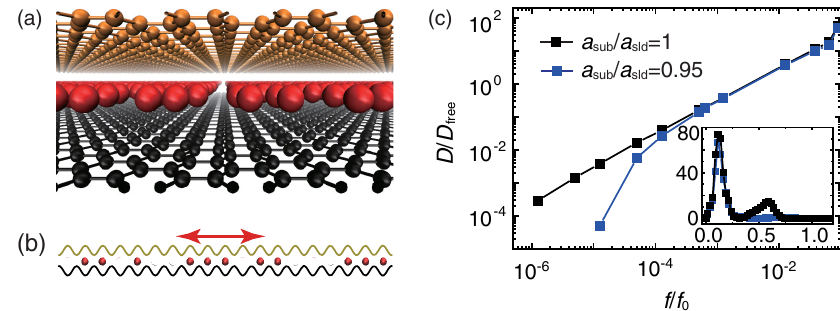
FIG. 1. Schematics of the studied systems and enhanced diffusion. (a) Schematic sketch of experimental configuration and (b) the model geometry, where red spheres represent particles embedded between two surfaces shown as black and yellow spheres (curves). The arrows in (b) indicate the directions of oscillations. (c) Dependence of normalized diffusion coefficient D=D oscillations f=f 0 calculated for commensurate ( a being the free diffusion coefficient and the oscillation amplitude A being A=a frequency